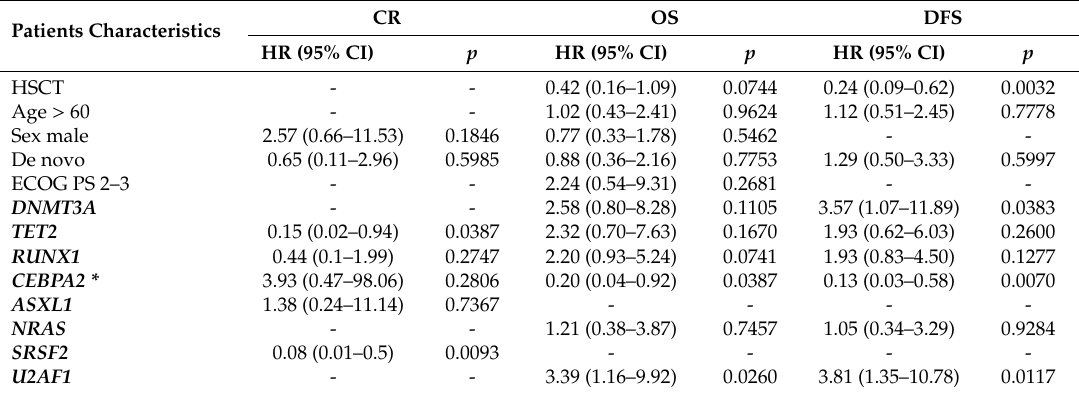
Table 5. Multivariate analysis for patients characteristics, treatments and mutations in FLT3 wt and NPM1 wt